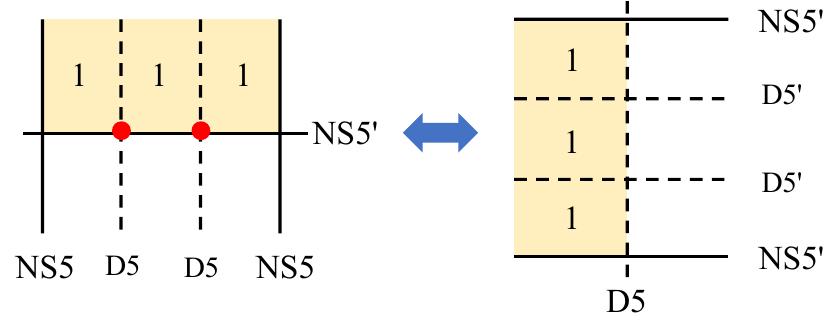
Γ ( i ) ) for T [SU(2)] and its dual , N (cid:31) + N (cid:31) { }